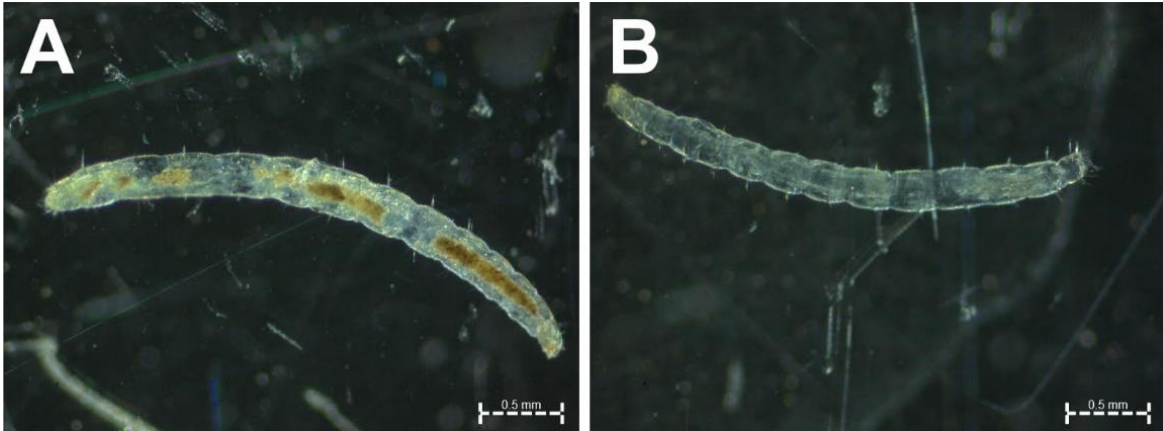
Figure 1. Images of flea larvae taken under a stereo microscope. Presence of soil or organic matter in the flea gut was observed in some larvae ( A ), but not all ( B ). The scale bars represent 0.5 mm.